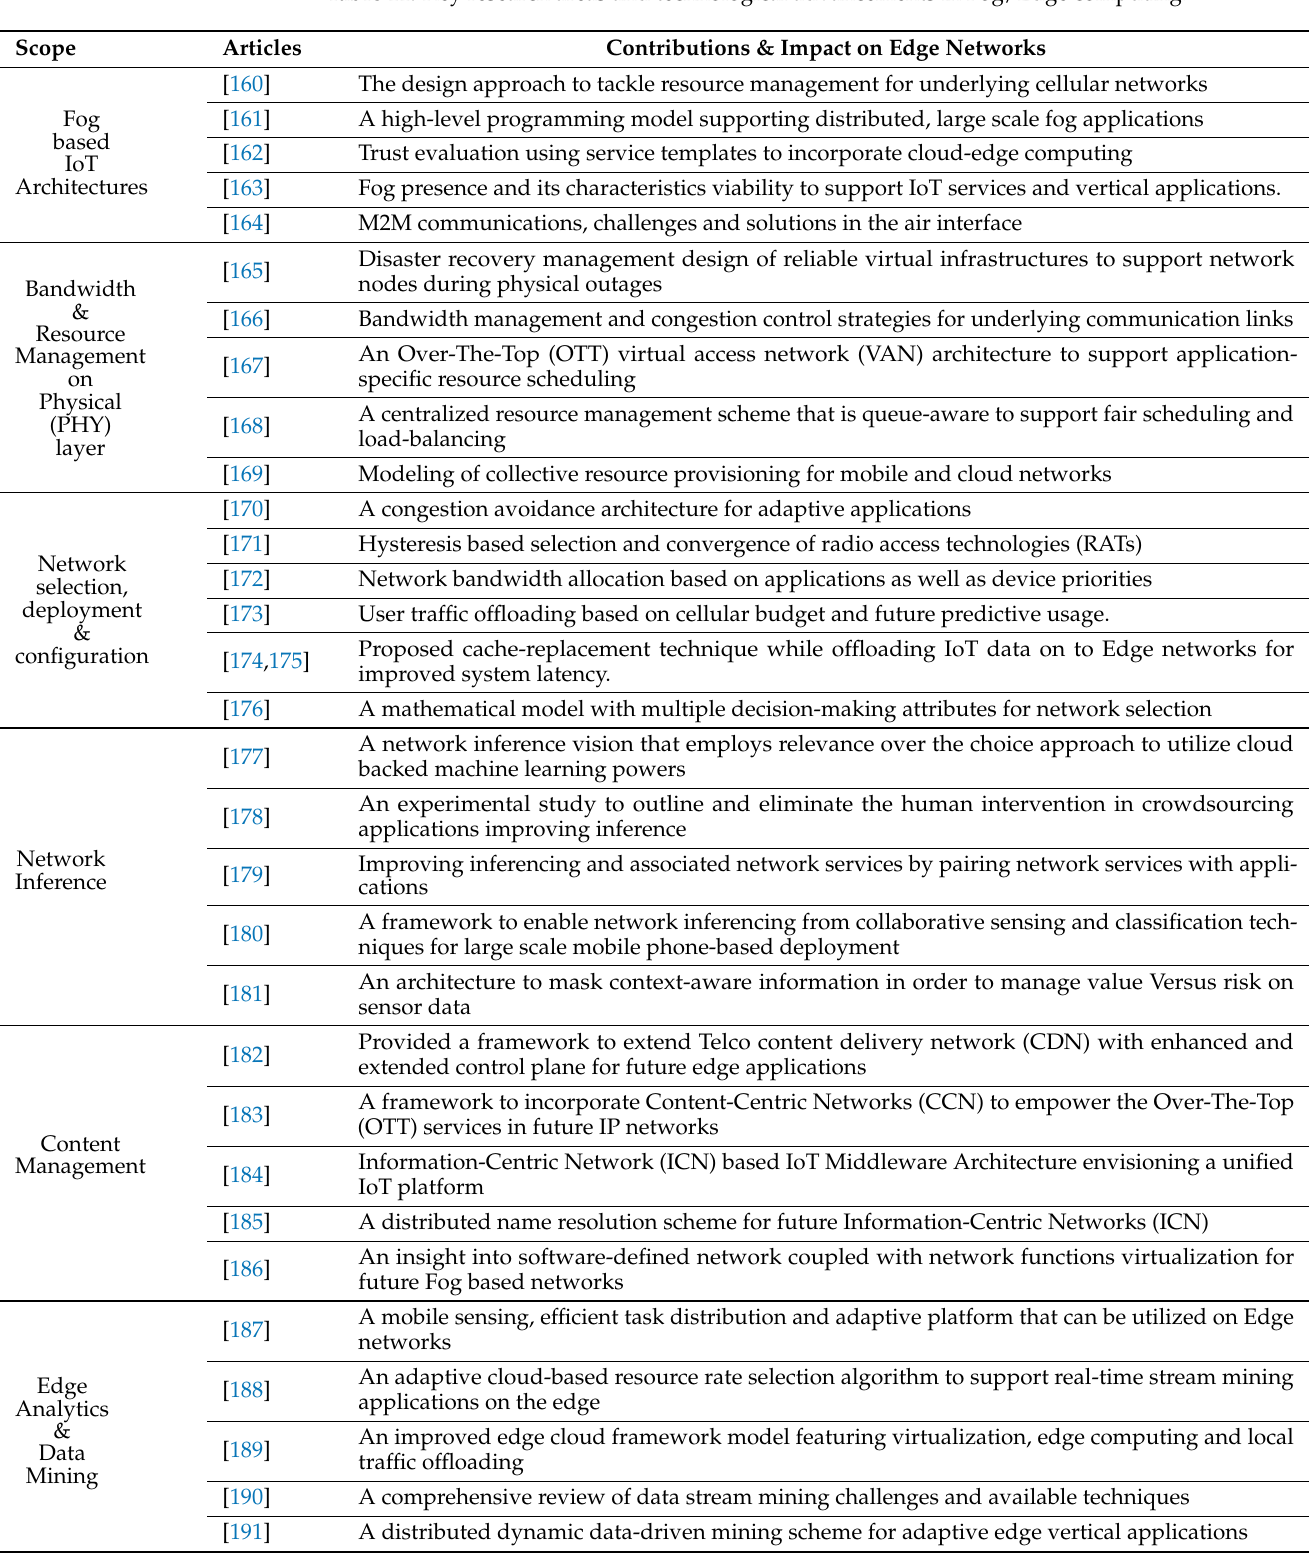
Table 11. Key research areas and technological advancements in Fog/Edge